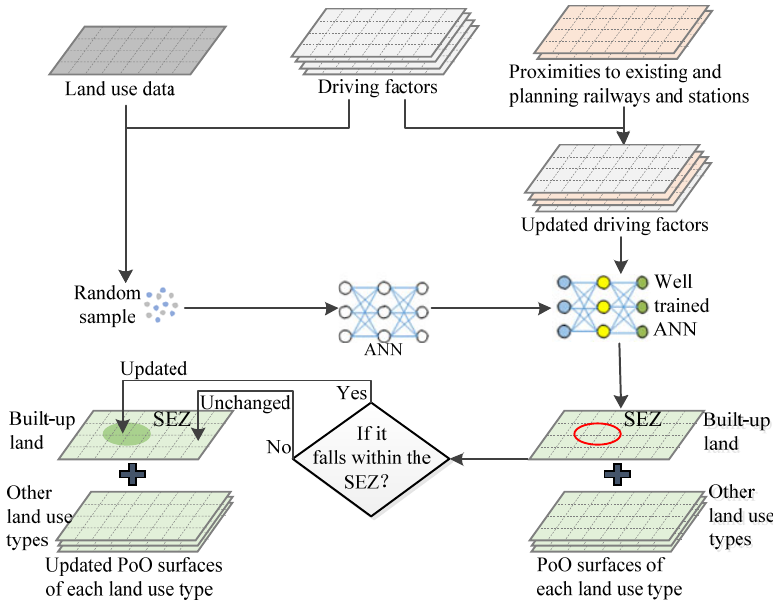
Figure 3. Framework of the proposed updated mechanism.